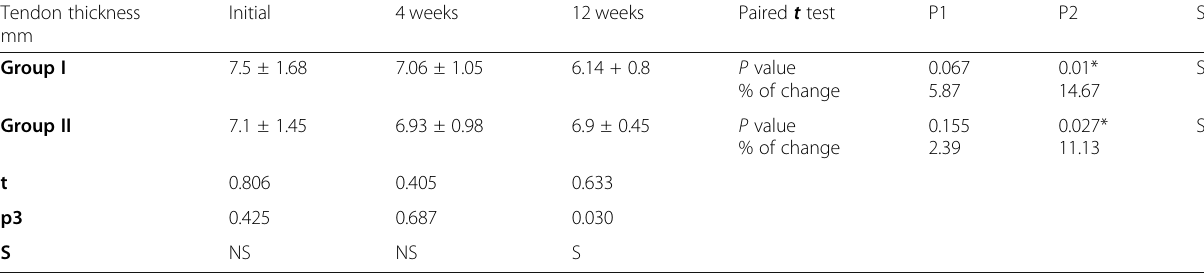
Table 4 The ultrasonic findings of the two groups initially, at 4 weeks and 12 weeks Tendon thickness mm